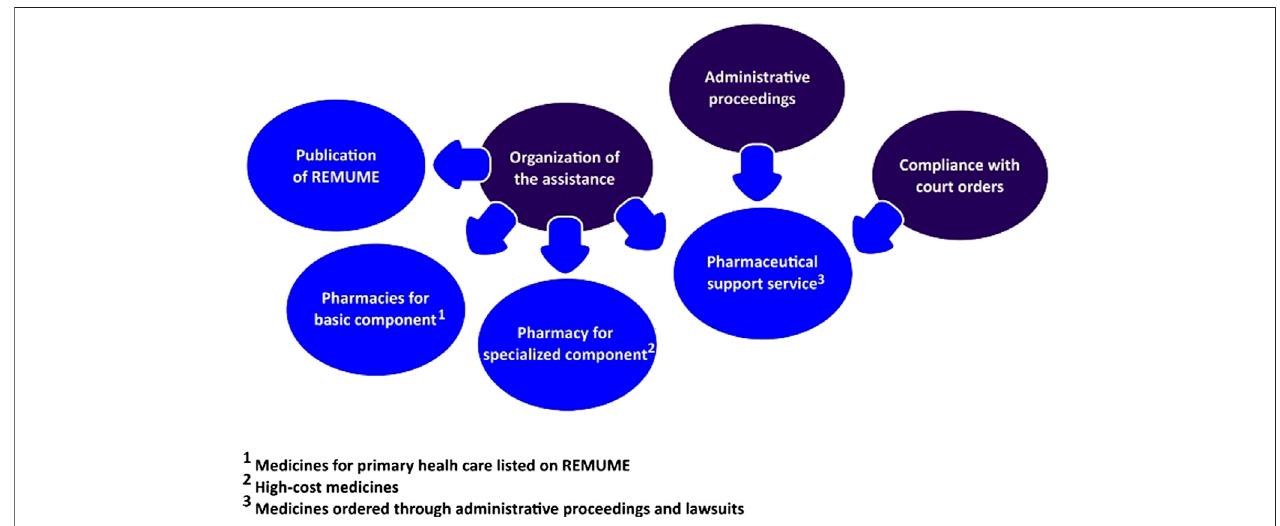
FIGURE 2 | Strategies implemented by the Municipal Secretary of Health to deal with medicines litigation.